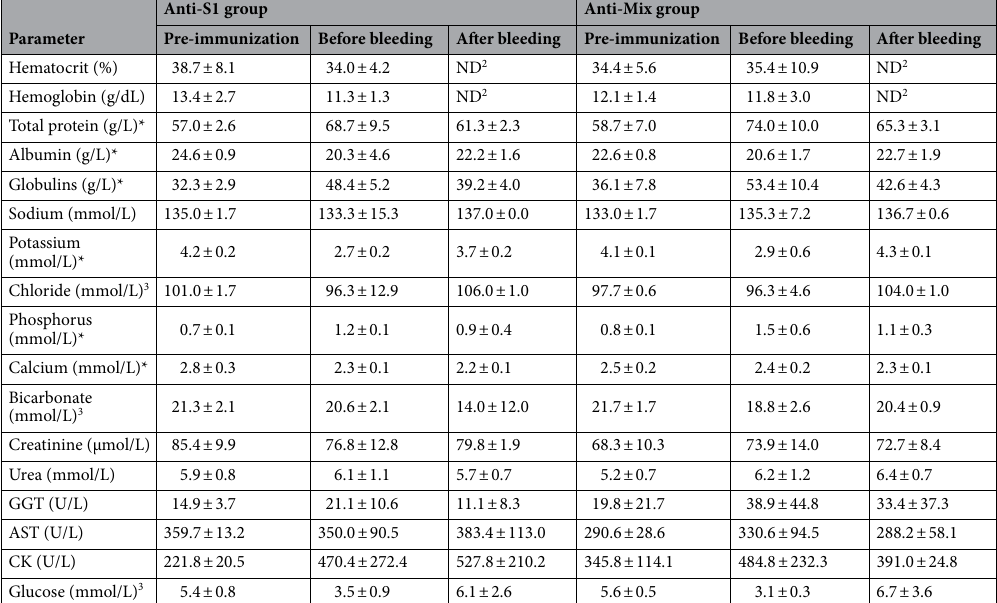
Table 2. Hematological and serum biochemical parameters of anti-S1 and anti-Mix groups of horses during immunization with SARS-CoV-2 recombinant proteins 1 . 1 Results are expressed as mean ± SD (n = 3 horses). 2 Not determined. 3 Did not comply with the assumption of sphericity; corrected with Greenhouse–Geisser factor. GGT: Gamma-Glutamyl Transferase; AST: Aspartate Aminotransferase; CK: Creatine Kinase. *Parameter changed significantly different over time (P <